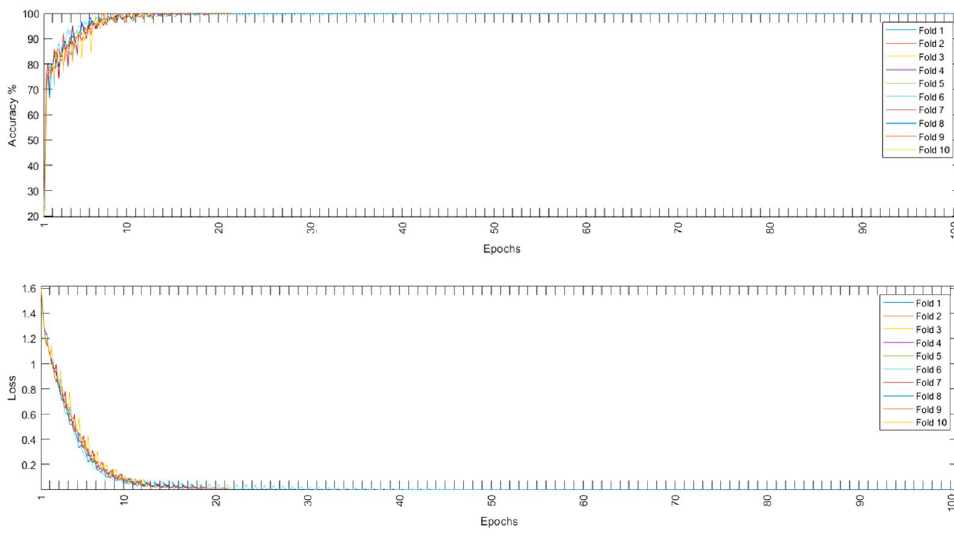
Figure 9. Non-augmented training accuracy and loss.